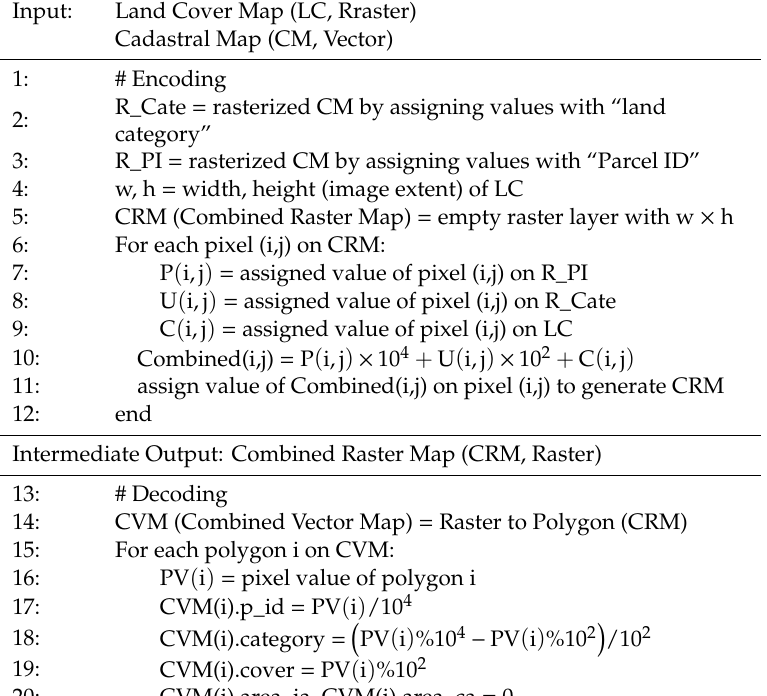
Table 1. Proposed algorithm of pixel-level inconsistency comparison.